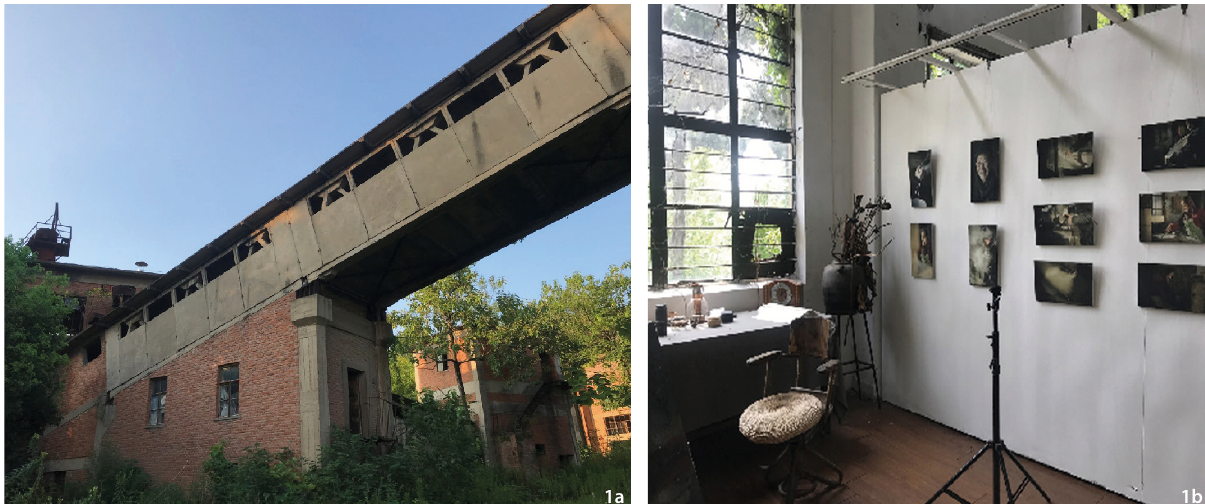
1a Figure 1a and 1b From an abandoned gypsum factory to an art space (Source: Mengchuan Liu).